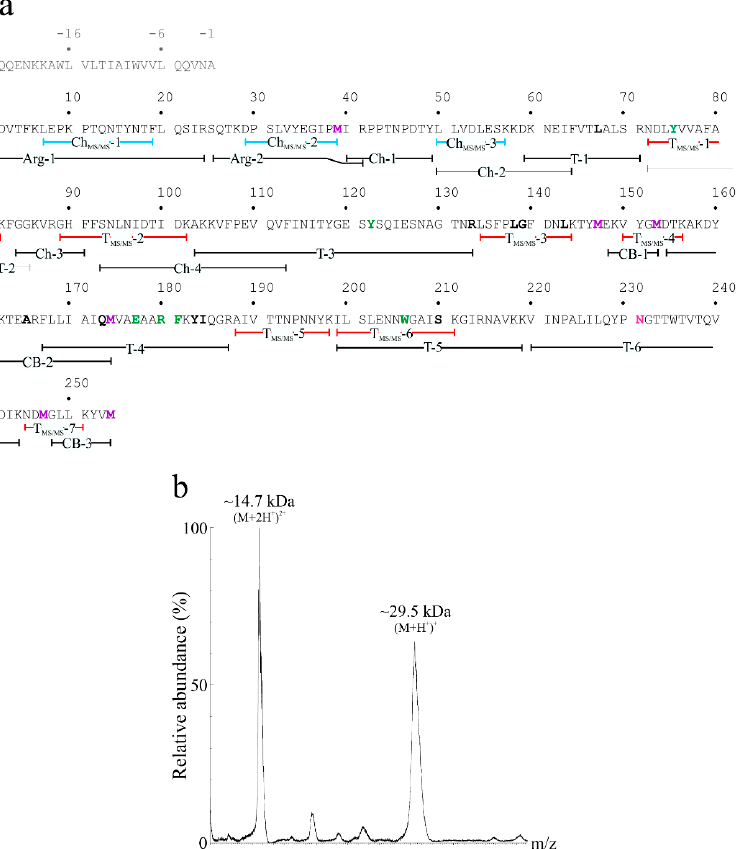
Figure 2. ( a ) Amino acid sequence of quinoin obtained using the protein synthesis inhibitor